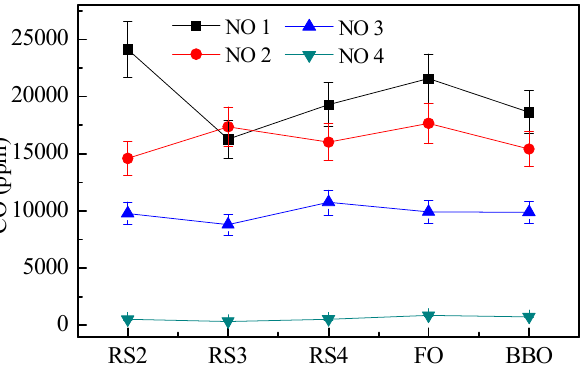
Figure 11. Comparison and trend of CO concentration at different measuring points under four condition tests.